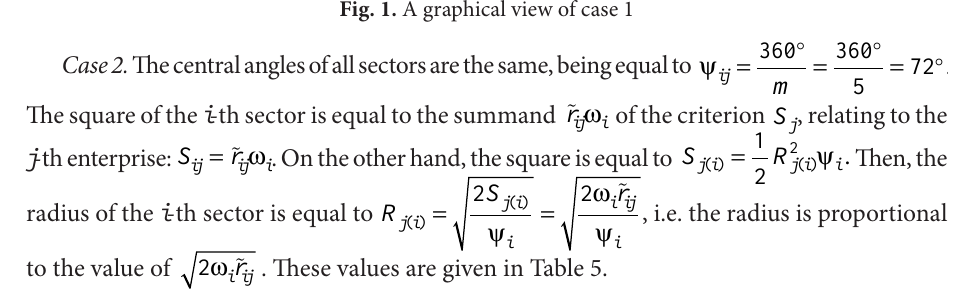
Fig. 1. A graphical view of case 1